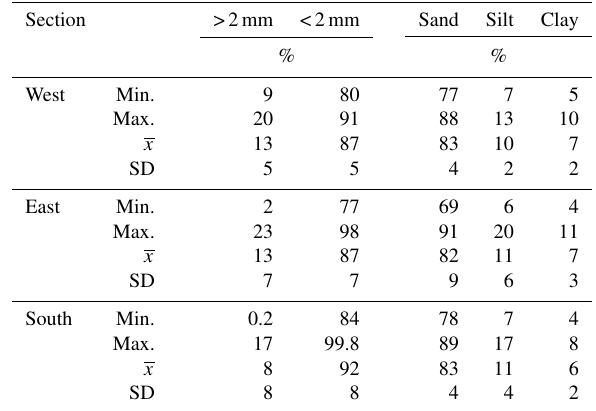
Table 1. Contents of skeleton (>2mm), fine earth (<2mm), sand, silt and clay fractions (upper 30cm) at the sampling points in west- ern, eastern and southern sections at Chicken Creek ( t 0 , calculations based on data of Gerwin et al., 2010). Minimal (min.) as well as maximal (max.) values, means ( x ) and standard deviations (SD) are